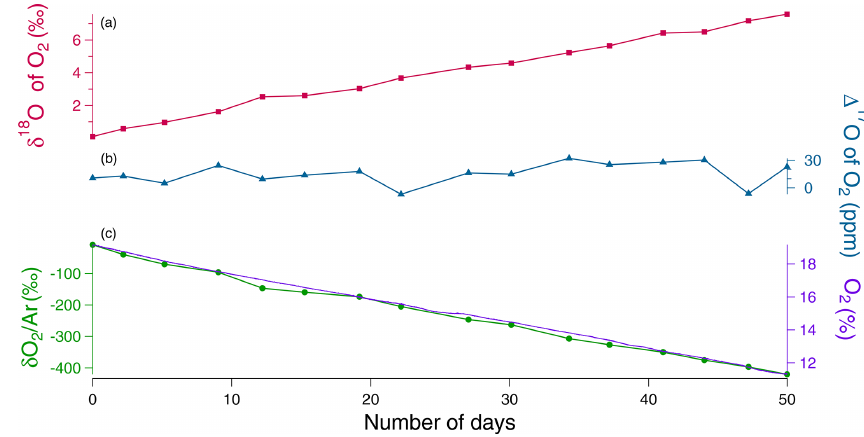
Figure 2. Evolution of the different concentrations and isotopic ratios in the sequence 2 of the soil respiration experiment (day 0 is the beginning of the sequence). (a) δ 18 O of O 2 (red) variations. (b) (cid:49) 17 O of O 2 (blue) variations. (c) Dioxygen concentration (purple) from the optical sensor and δ O 2 / Ar variations (green) measured by IRMS.